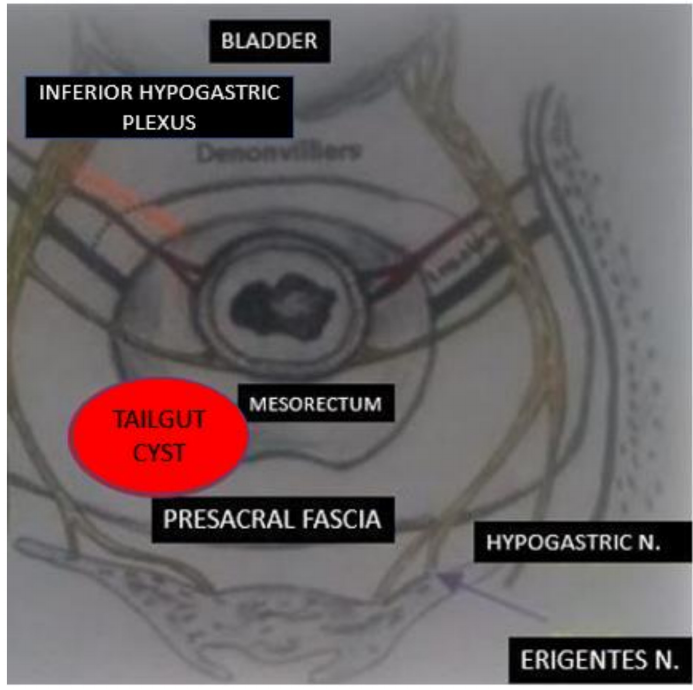
Figure 2. Location of this cystic mass and surrounding organs.